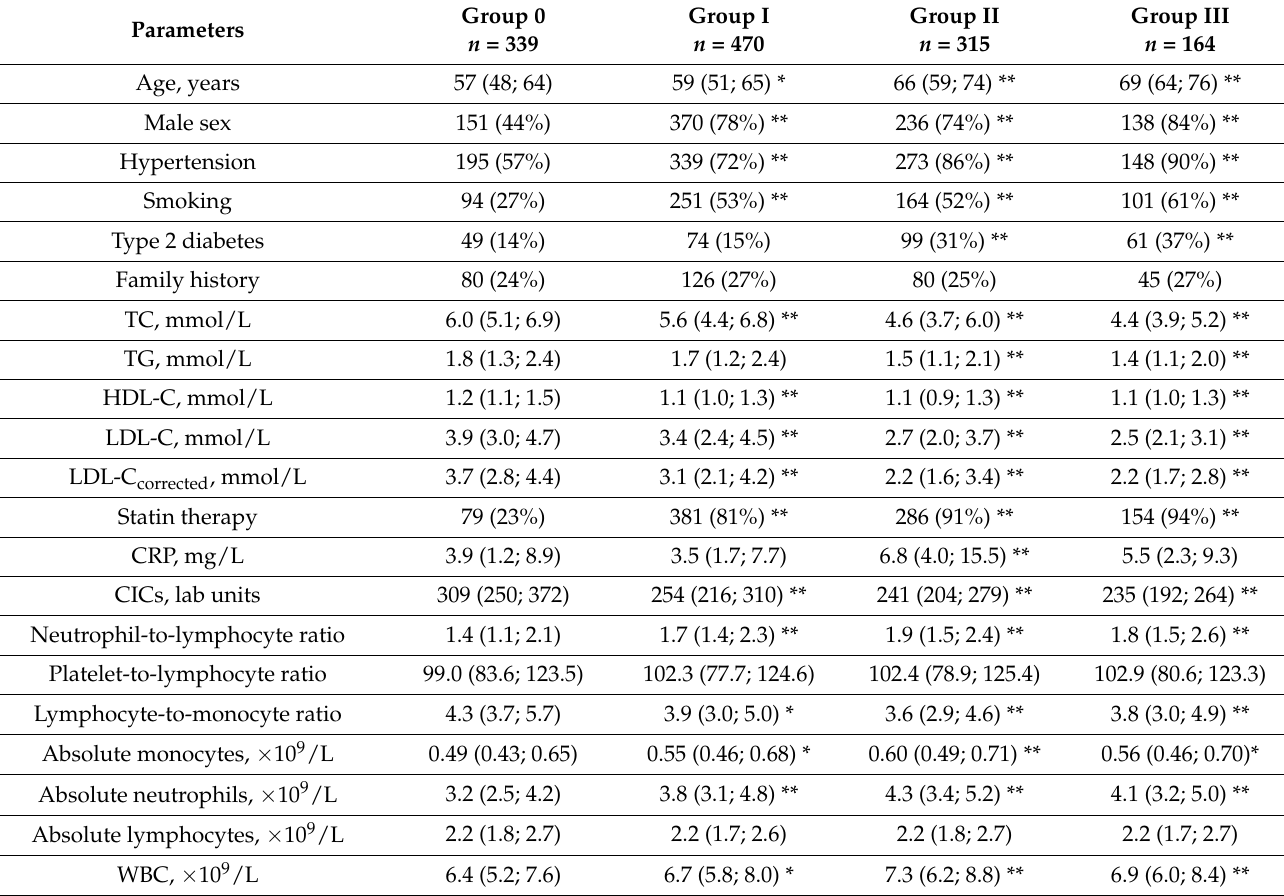
Table 1. General characteristics of examined